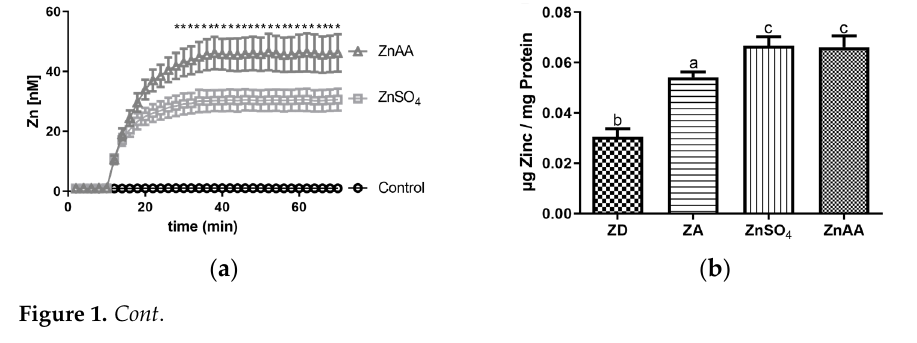
Figure 1. ( a ) A total of 1 × 10 6 SF cells per ml were loaded with FluoZin3-AM, base line fluorescence was recorded for 10 min and increase in fluorescence after adding ZnSO 4 (50 µM) or ZnAA (50 µM) was monitored for additional 60 min. ( b , c ) SF cells were cultured in CHELEX-treated medium, zinc adequate (ZA) medium or medium supplemented with ZnSO 4 (50 µM) or ZnAA (50 µM) for 7 days. Afterwards total zinc of the cells was analyzed using AAS or mRNA was isolated and used for measuring MT mRNA expression normalized to EF1A. Mean values + S.E.M. of at least n = 7 inde- pendent experiments are shown. Significant differences between ( a ) ZnSO 4 and ZnAA (multiple t tests, * p < 0.05) are marked. In ( b , c ), significantly different data sets as determined by one-way Anova and Tukey’s post hoc test do not share the same letters ( p < 0.05). 3. Results 3.1. Zinc Homeostasis in Zinc Deficient and Zinc Supplemented SF Cells It has been hypothesized that the uptake of zinc into cells strongly depends on the chemical nature of the zinc compound used and that zinc in complex with sulfate, glu- conate, aspartate or other amino acids is taken up by cells with differing efficiency. Thus, as a first step, the uptake of zinc sulfate (ZnSO 4 ) and a zinc-amino acid complex (ZnAA) into SF cells was analyzed using the zinc-specific probe FluoZin3 AM. As depicted in Fig- ure 1a, ZnSO 4 and ZnAA were taken up by the cells. Maximum intracellular zinc levels were reached 30 min after adding the supplement. However, the amount of zinc taken up by the cells during this time was significantly higher when ZnAA was added compared to ZnSO 4 (Figure 1a). To evaluate if this difference was limited to short incubation times, total cellular zinc was measured 7 days after supplementation was started. As in the short-term incubation, both ZnSO 4 and ZnAA incubation resulted in a significant increase in total cellular zinc. However, interestingly, no difference was observed at 7 days when total cellular zinc was measured by atomic absorption spectrometry (Figure 1b). In line with this, the expression of metallothionein, the most important intracellular zinc-binding protein, was signifi- cantly increased by ZnSO 4 and ZnAA in the same magnitude (Figure 1c). When cells were cultured in medium where zinc had been depleted using CHELEX resin, total cellular zinc was significantly decreased compared to cells cultured in zinc-adequate conditions (Fig- ure 1b) as was also observed for the expression of metallothionein (Figure 1c). 3.2. Zinc Transporter Expression in SF Cells Aiming at a more detailed characterization of zinc homeostasis and at finding an ex- planation for the changes in the zinc status of SF cells, the expression of zinc importing transporters was analyzed. No data on the expression of zinc transporters in cells from